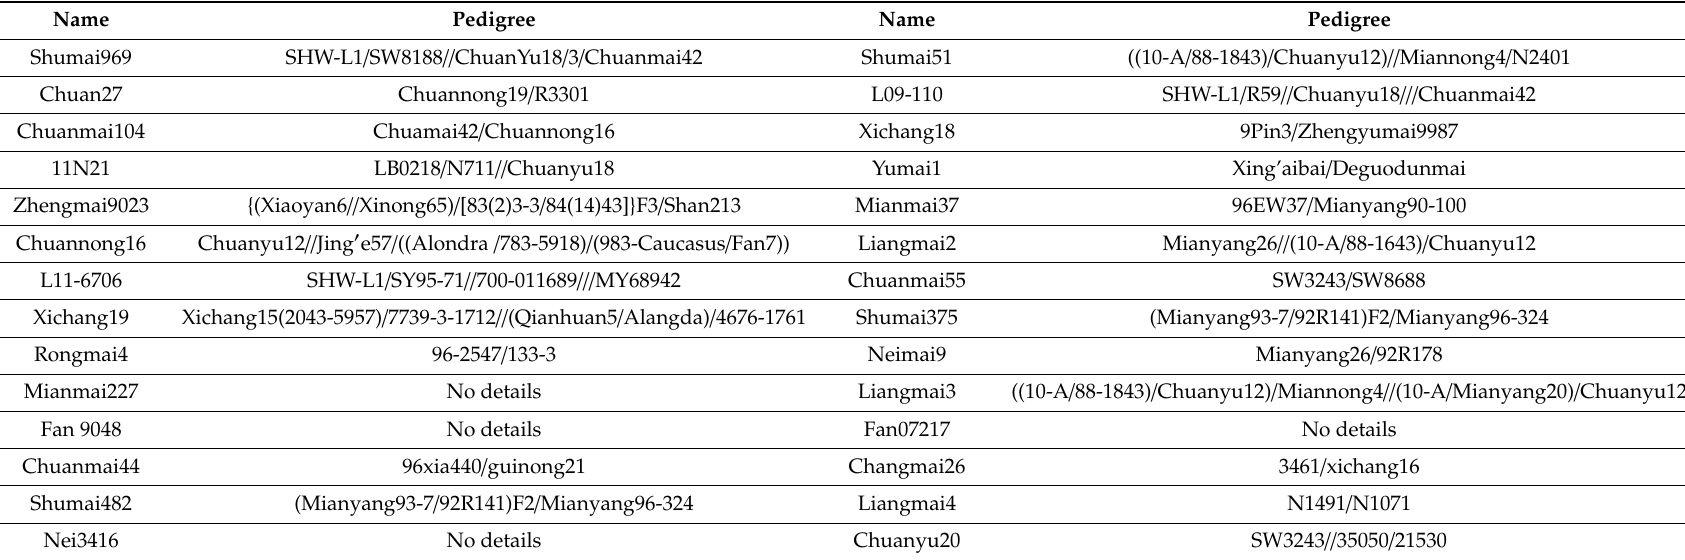
Table 1. Materials and pedigree.